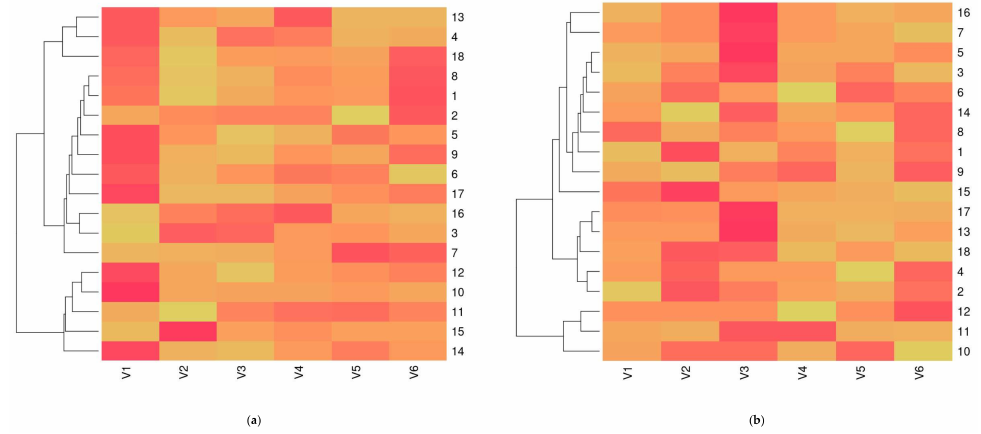
Figure 4. Sensory perception of resulted wines: ( a )—Feteasc ă regal ă ; ( b )—Sauvignon blanc. 1